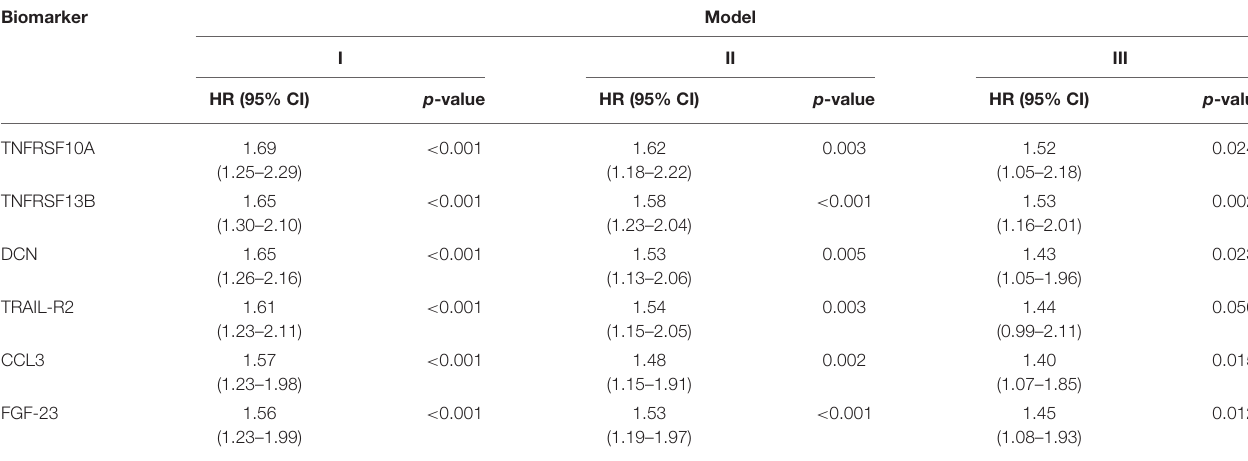
TABLE 3 | The relation between TNFRSF10A, TNFRSF13B, DCN, TRAIL-R2, CCL3, and FGF-23 and the risk of MACE. Biomarker